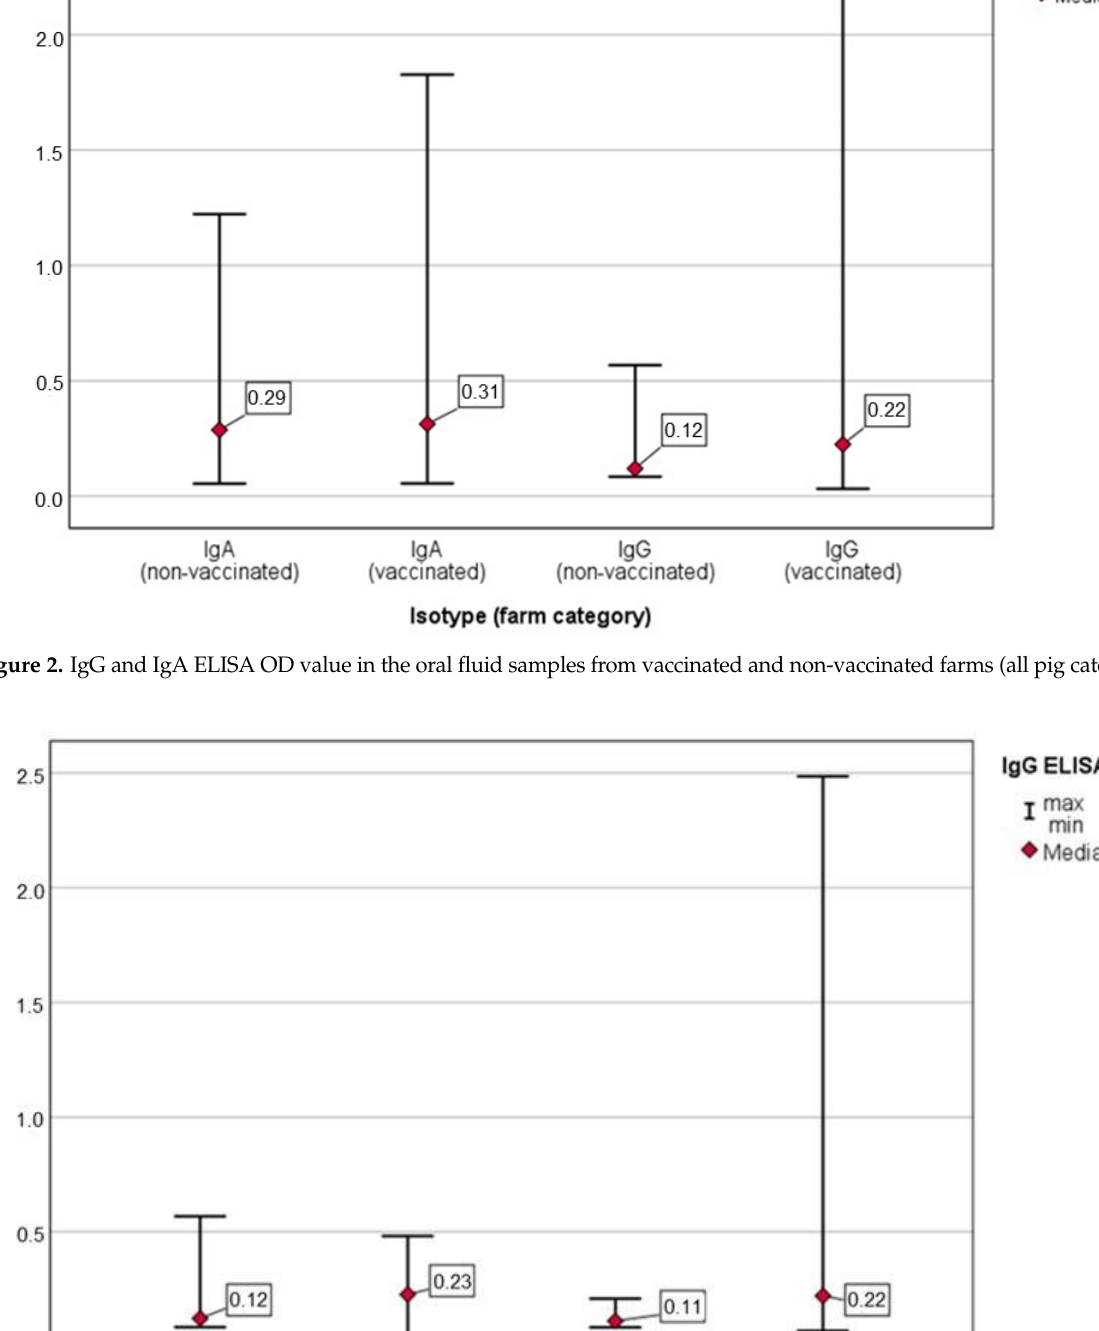
Figure 3. IgG ELISA OD value in the oral fluid samples from sows and offspring in vaccinated and non-vaccinated farms.